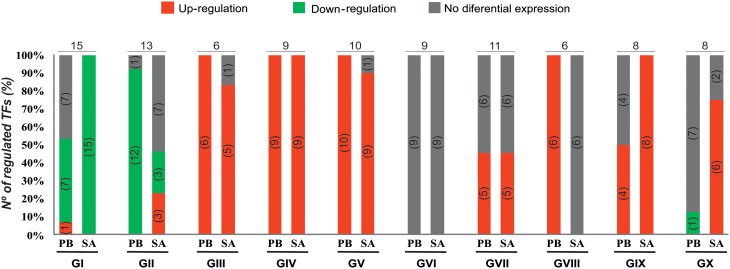
Expression profiles of TF genes. Percentages and numbers (into the brackets) of up-regulated (in red), down-regulated (in green), and no differential expressed (in gray) genes detected in Parabinga (PB) and SA1306 (SA) for each of the 10 clusters (groups GI–GX). Top on each cluster the total number of TF regulated genes is indicated. Additional information is available in Table 1.